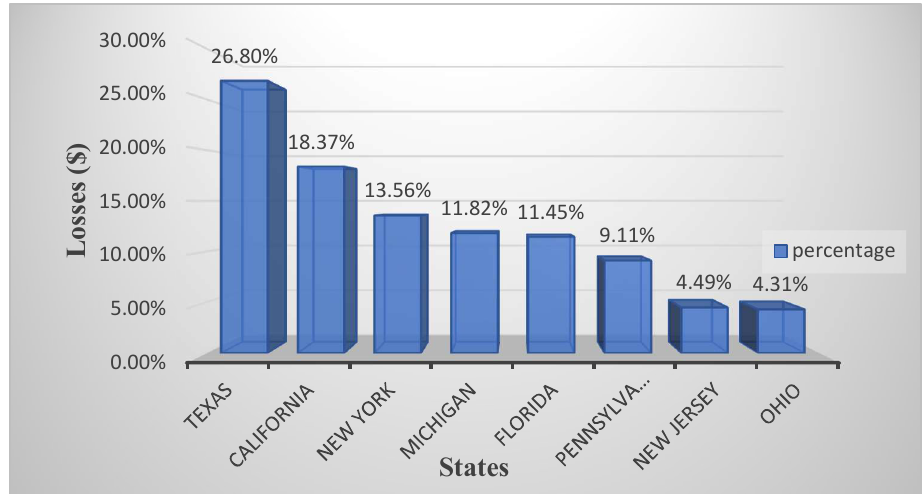
Figure 6. Percentage dispersal of revenue loss in top eight States.